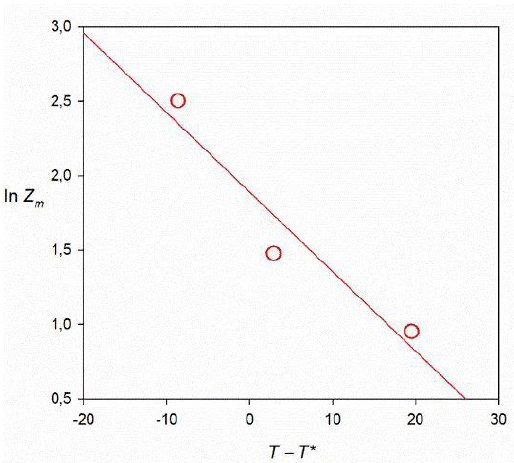
Figure 3. Logarithm of the average torque as a function of different chamber wall temperatures (265, 280 and 295 °C); reference temperature T* = 280 °C at the 8 -10 min interval for tests performed at a set rotor speed (60 rpm).